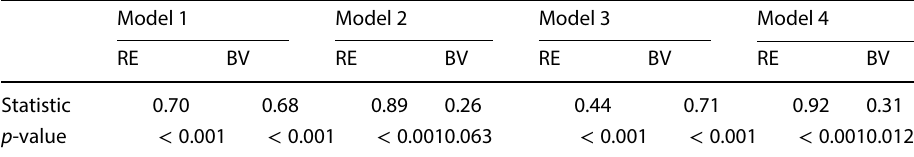
RE the reconstruction error approach, BV the